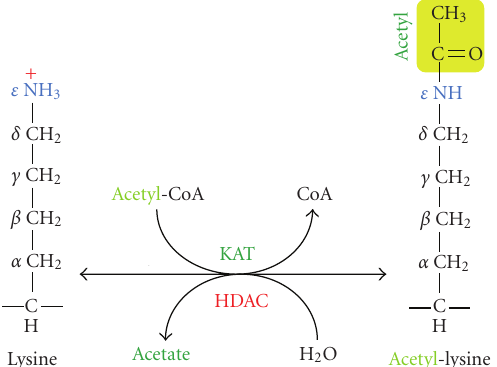
Figure 1: Cartoon illustrating acetylation and deacetylation at the ε -amino group of a lysine residue. A KAT is responsible for transfer of an acetyl moiety (in yellow) from acetyl-CoA to the ε -group of a lysine residue, whereas an HDAC removes the acetyl group from acetyl lysine, releasing acetate. Note that sirtuins use a catalytic mechanism that is completely di ff erent from what is illustrated here for the Rpd3/Hda1 family of